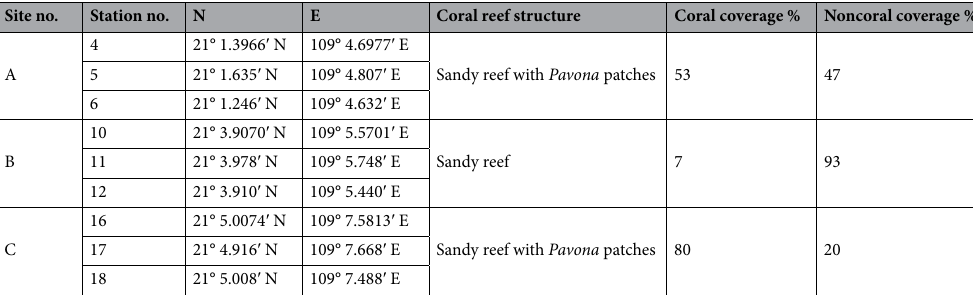
Site no. Station no.